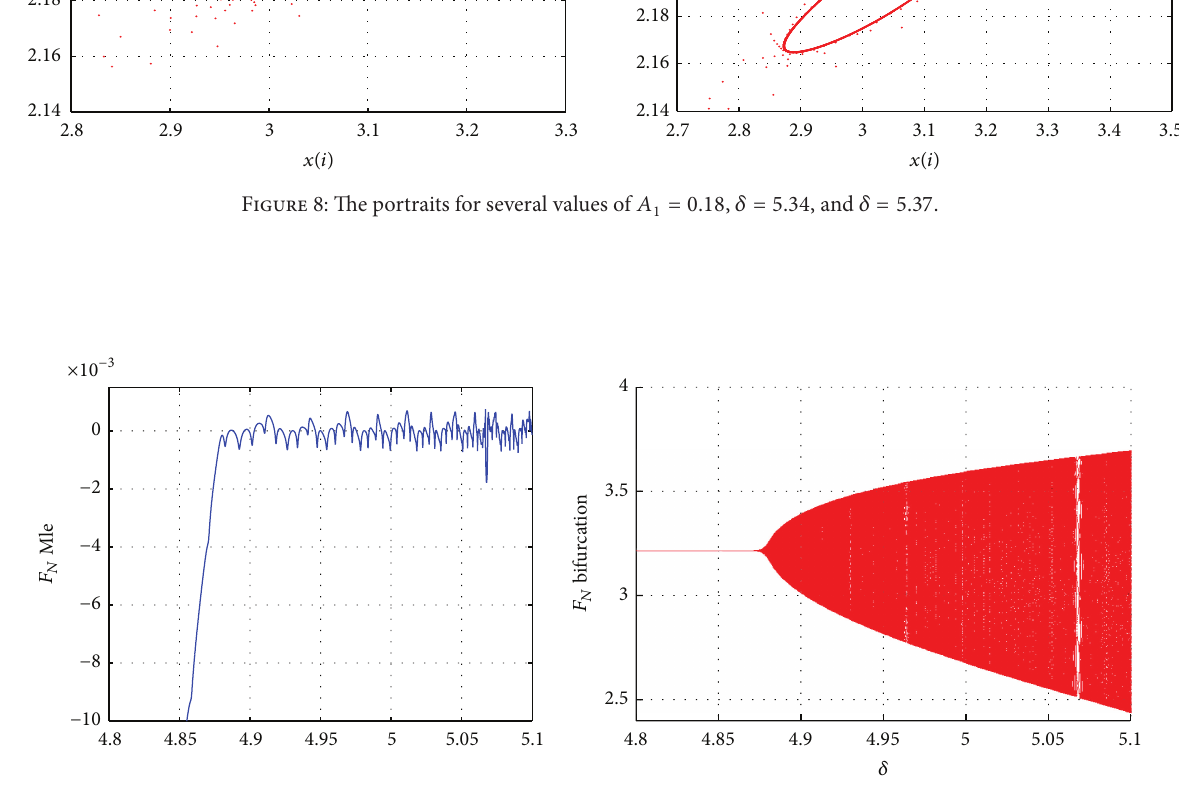
Figure 9: Largest Lyapunov exponents and bifurcation diagram of system (25) for 𝑎 = 0.8 , 𝑏 = 0.8 , 𝑐 = 0.4 , 𝑑 = 0.2 , 𝑘 = 5 , 𝑙 = 3 , and = 0.03 with the initial value of (𝑥,𝑦) = (1,1) and 𝛿 covering [4.8, 5.1] . 𝐴 1